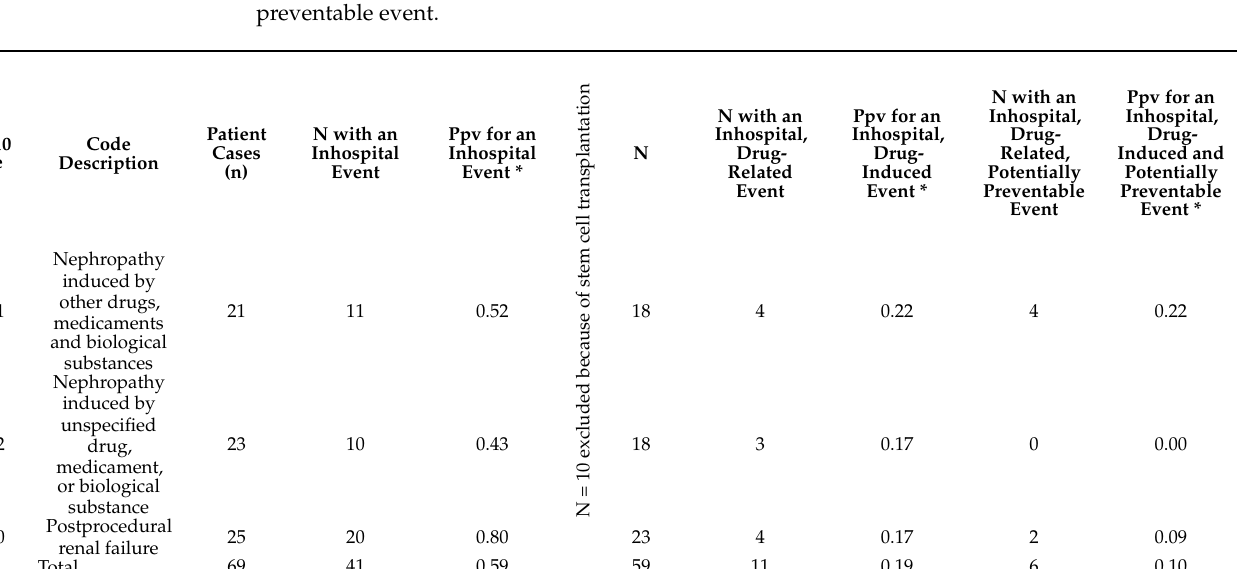
Table 1. ICD-10 codes used for drug-induced nephropathy or postprocedural renal failure and corresponding positive predictive value (ppv) for an inhospital, drug-induced, and potentially preventable